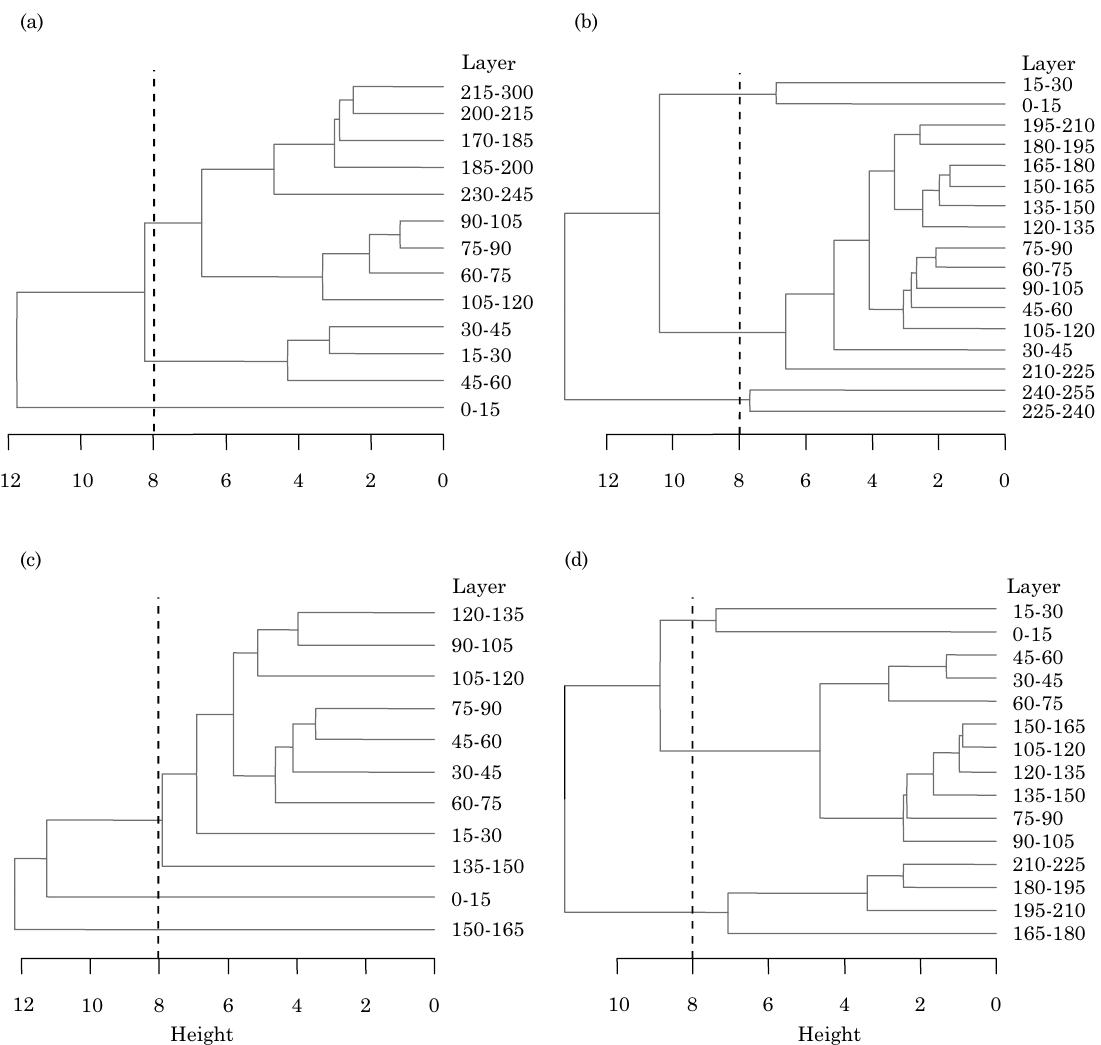
Figure 6. Dendrograms of Hierarchical Cluster Analysis of layers of peat soil core samples of the Rio Preto under (a) Wet grassland (WGL) and (b) Semi-deciduous forest (SDF); and of the Córrego Cachoeira dos Borges under (c) Wet grassland (WGL) and (d) Semi-deciduous forest (SDF), according to Euclidean distance (unweighted pair group method with arithmetic mean - UPGMA) using 34 physical, chemical, and elementary properties that were self-scaled by the mean and the standard